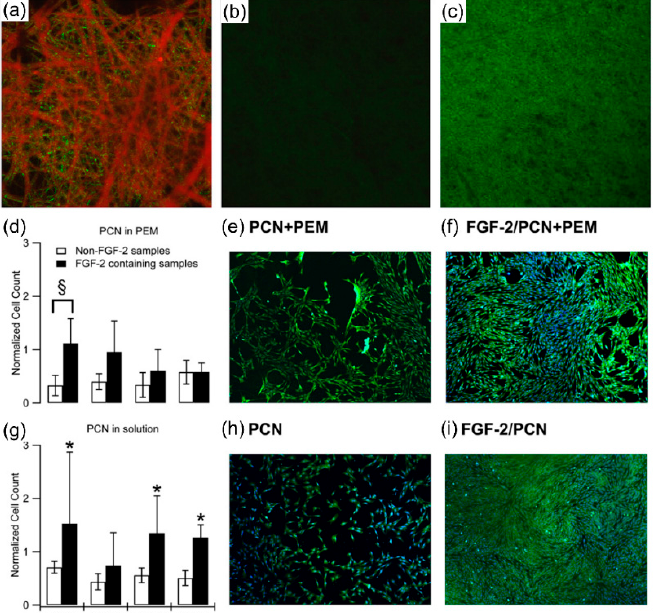
Figure 9. ( a ) Confocal microscopy images using × 63 objective of rhodamine-modified chitosan fiber network (red) with FGF-2 LB /PCN complexes adsorbed (green). ( b , c ) Confocal microscopy images (using × 20 objective) of FGF-2 LB /PCN fibers and FGF-2 LB /PCN + PEM fibers after 30 days of release at 37 ◦ C. ( e , f , h , i ) Representative fluorescence microscopy images of MSCs stained with DAPI (nuclei) and calcein-AM (cytoplasm). ( d – f ) Cells cultured on TCPS coated with chitosan, PCNs (or FGF-2/PCN complexes), one bilayer of TMC–heparin PEM, and fibronectin. ( g – i ) Cells cultured on fibronectin-coated TCPS with PCNs (or FGF-2/PCN complexes) delivered in solution. § in ( d ) indicates statistically different results for the two conditions. * in ( g ) indicates that the FGF-2/PCN-complexes preconditioned for 1, 18, and 27 days in solution result in cell densities that are statistically different from all other conditions in both ( d ) and ( g ) that correspond to the same preconditioning time (n = 3, p < 0.05). Reproduced with permission from [78], Copyright © 2021 Acta Materialia Inc. Published by Elsevier Ltd., Amsterdam, The